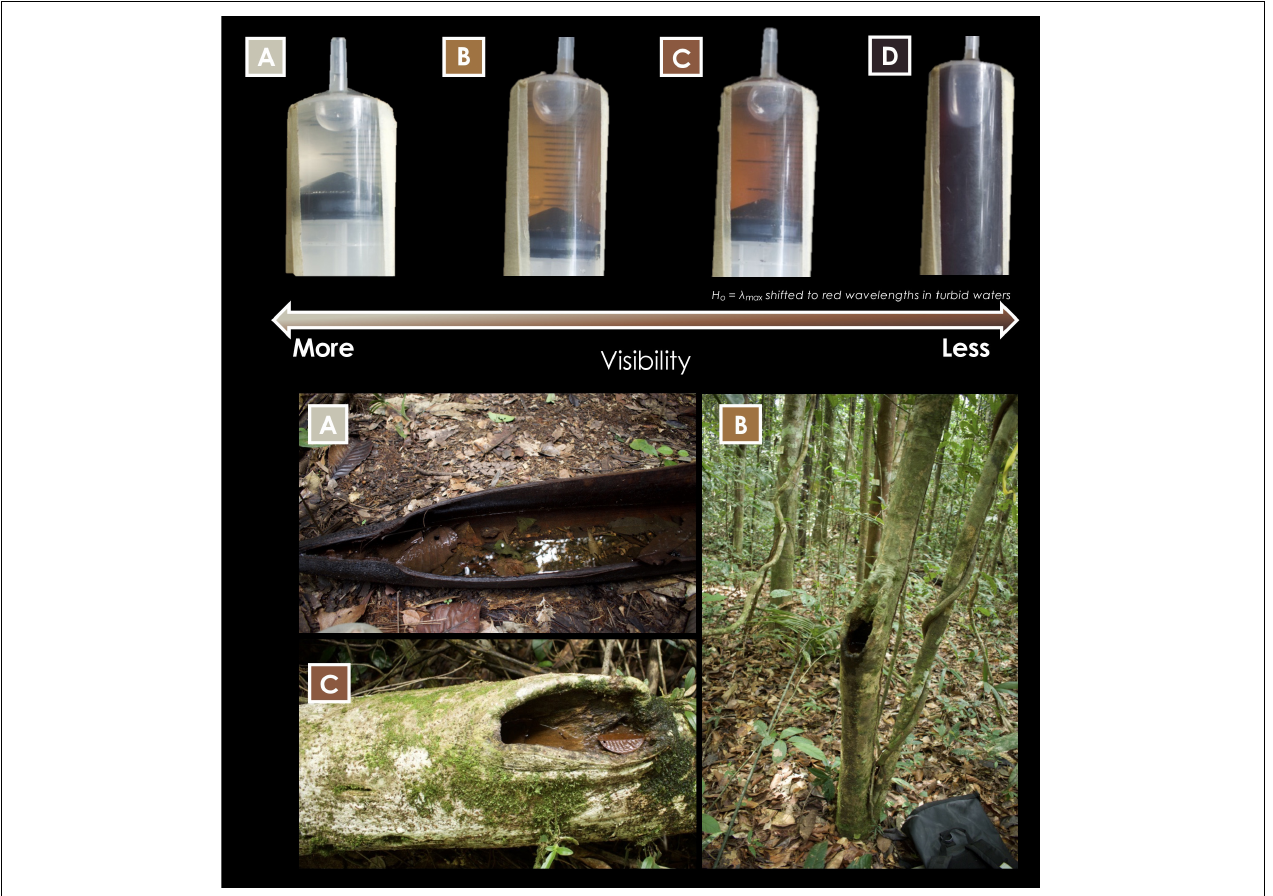
FIGURE 1 | Water samples (collected by CF) from phytotelmata occupied by Dendrobates tinctorius tadpoles in French Guiana. Based on water samples, it appears that tadpoles are deposited in pools with a wide range of visibility. Colored labels refer the water sample (top of figure) to the pool from which it was collected. We hypothesize that in darker waters tadpoles’ spectral sensitivity is red-shifted (lower Vitamin A1:A2 ratio). Photos: Chloe A.